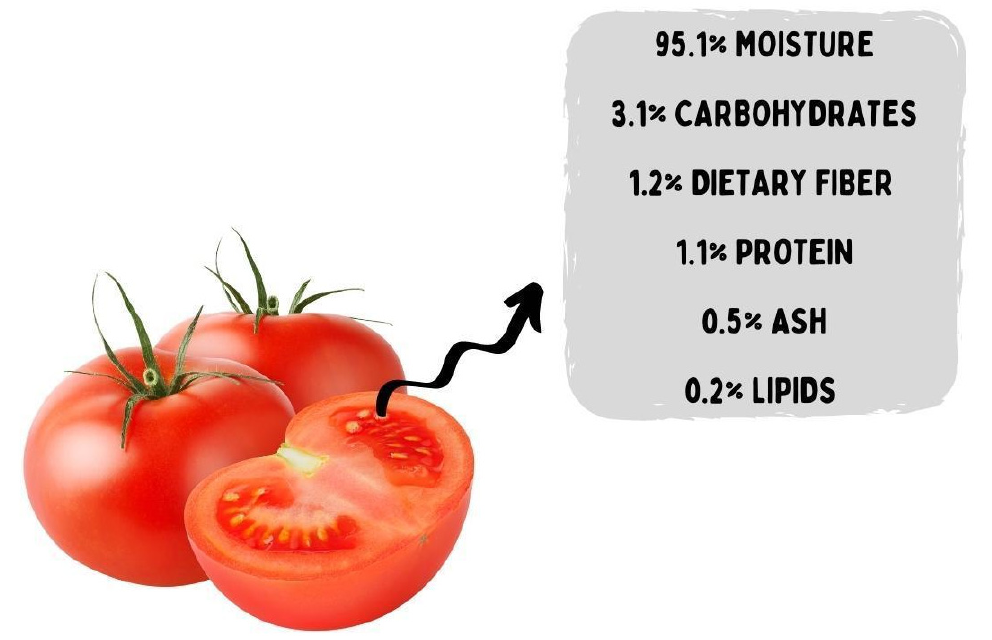
Figure 1. Chemical composition of tomatoes.